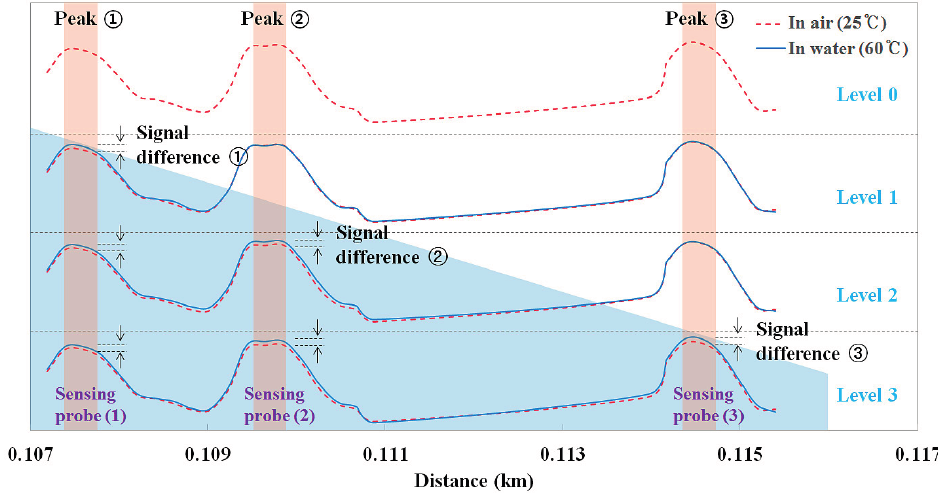
Figure 10. Variation of the output signals of the fiber-optic water level sensor according to the water